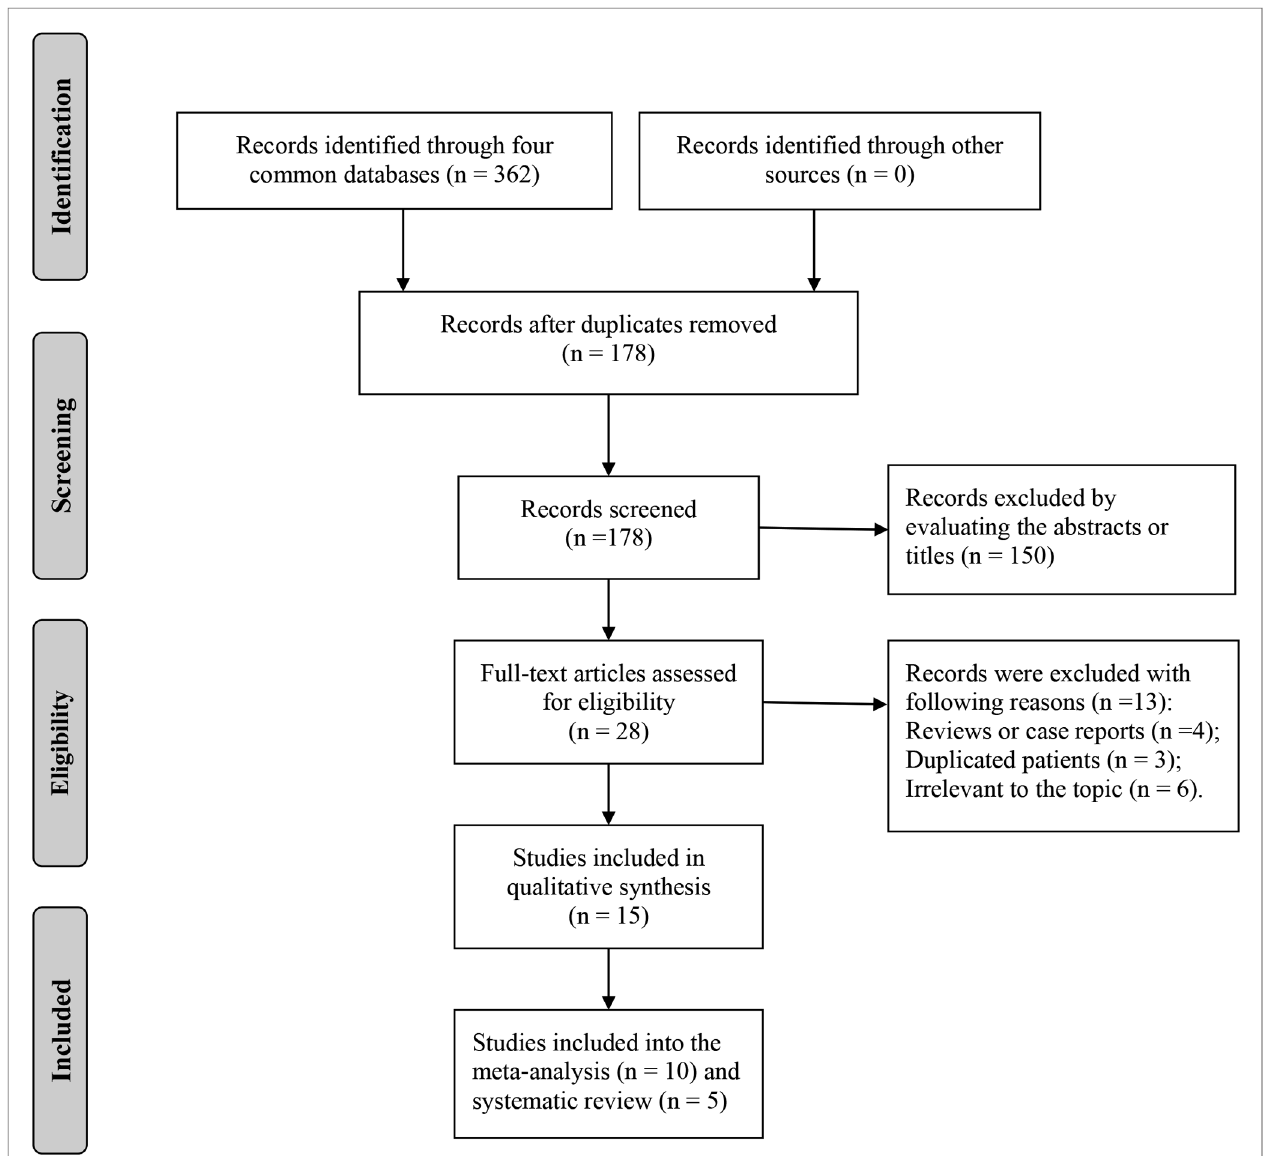
FIGURE 1 | Flow diagram of literature search and